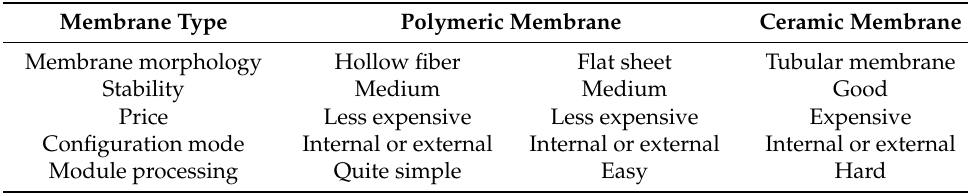
Table 6. Comparison of different types of membranes; adapted from [116].